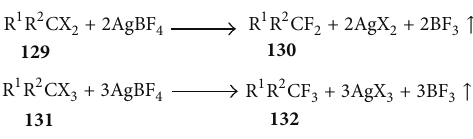
Scheme 31: Exchange-fluorination by reaction with AgBF 4 .